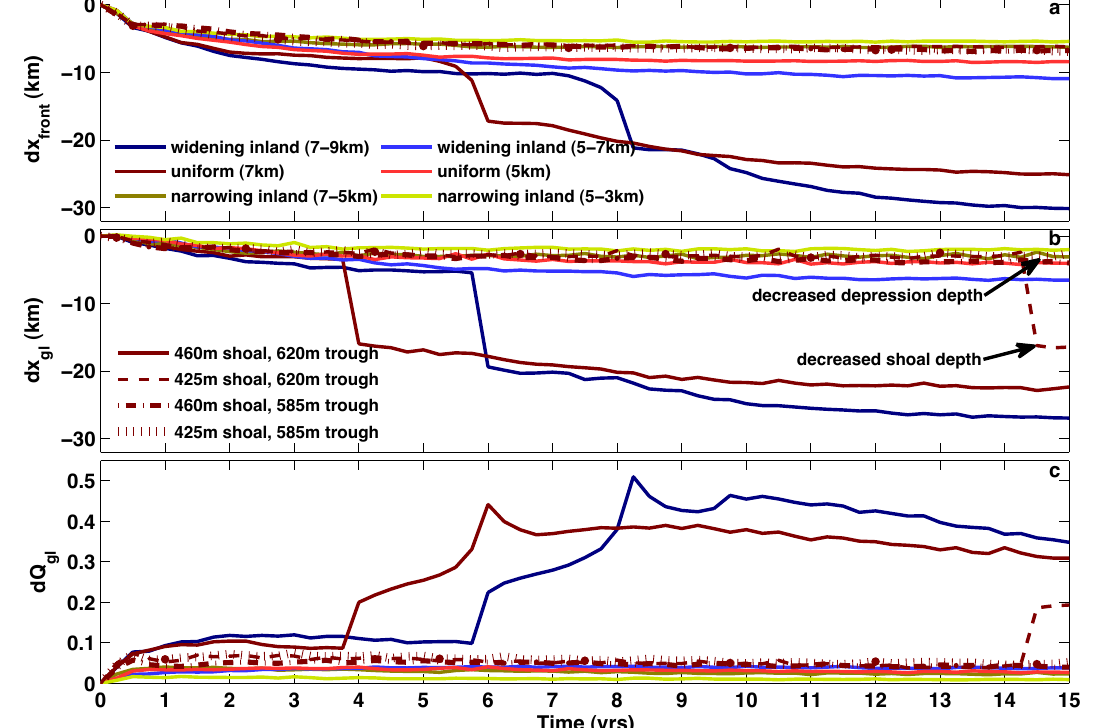
Fig. 4. Time series of modeled (a) front position change, (b) grounding line position change, both relative to their respective initial positions, and (c) the fractional increase in grounding line discharge following the perturbation onset relative to the initial steady-state